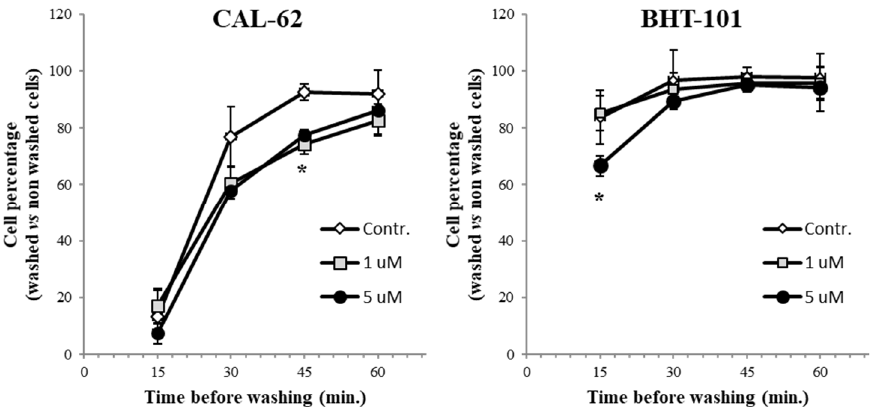
Figure 3. Adhesion assay . Cells pre-treated with increasing doses of WX-340 for 24 h were detached with trypsin/EDTA, counted, and seeded in a 96-well plate. Separate well rows were washed after 15 min., 30 min., 60 min., or not washed. Finally, WST-1 was added to all wells and the OD was measured 2 h later. * p < 0.05.